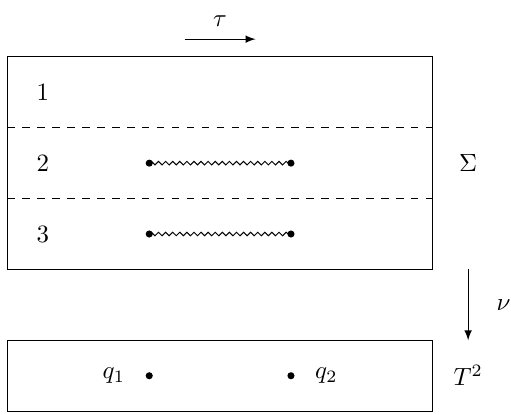
1 ; q 2 . The 1 ; 2 3 ; 3 2. A vertical time slicing of (cid:6) ! ! !